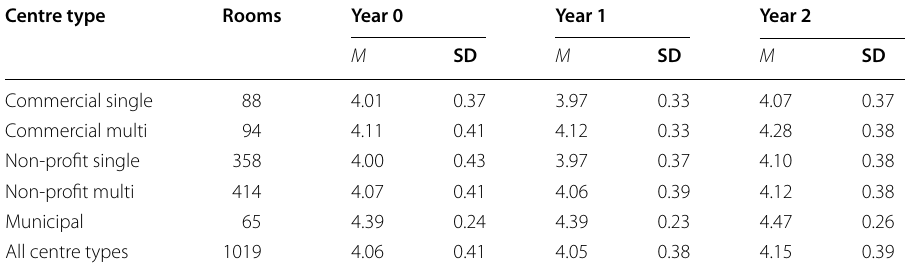
Table 2 AQI Scores by centre type and year Centre